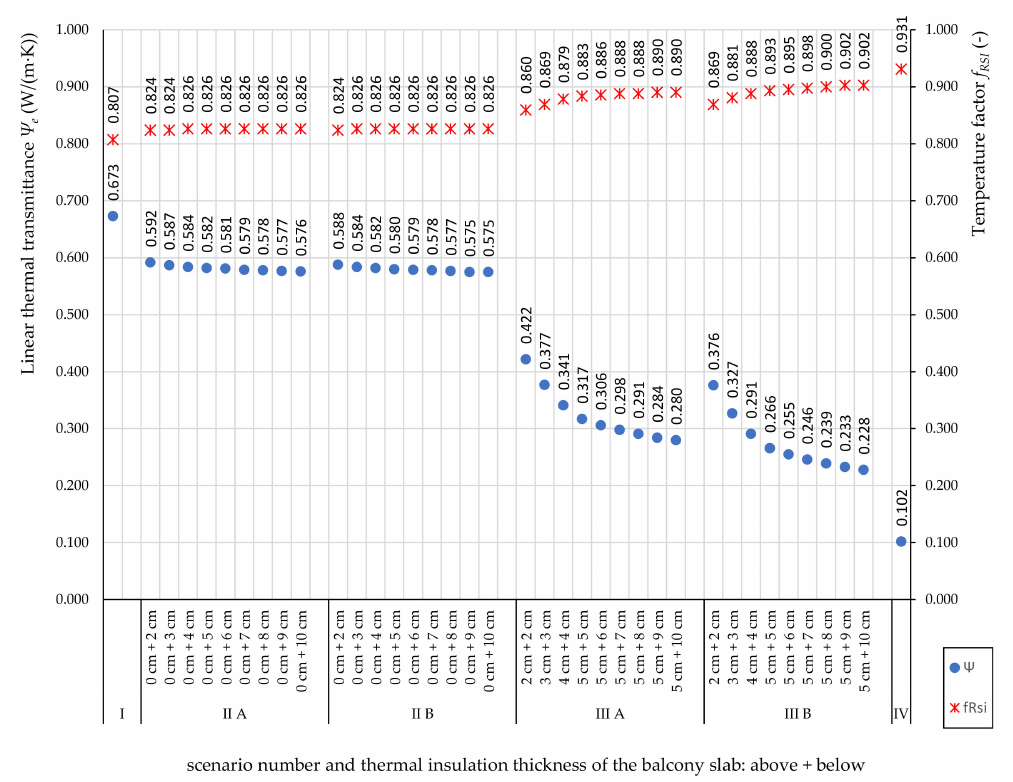
Figure 4. The linear thermal transmittance and temperature factor for the location of the building in Bialystok, when the walls of a large-panel building have been insulated with an additional 12 cm thick thermal insulation.